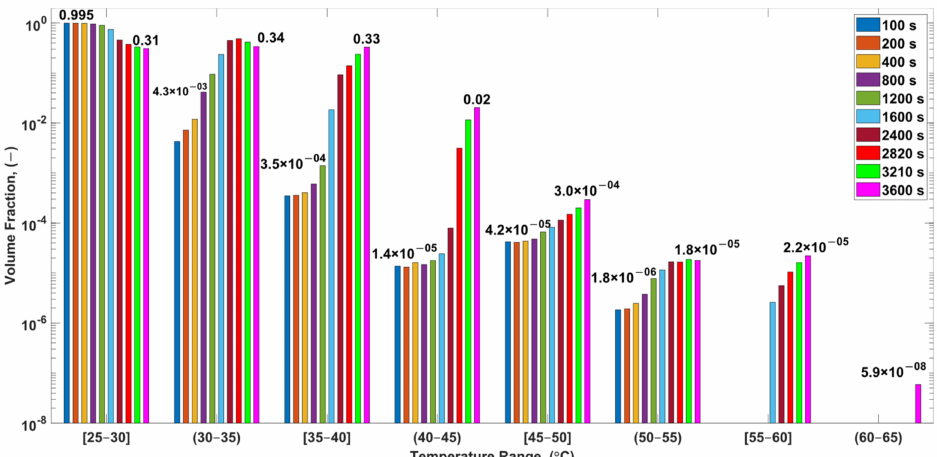
Figure 10. Temporal variation in volume fractions on a logarithmic scale with respect to the tempera- ture range in the suppression pool for the base case (Case F). It can be seen that, at a time of 3600 s, about 97% (or 0.31 + 0.34 + 0.33) of the pool volume is at a temperature lower than 40 ◦